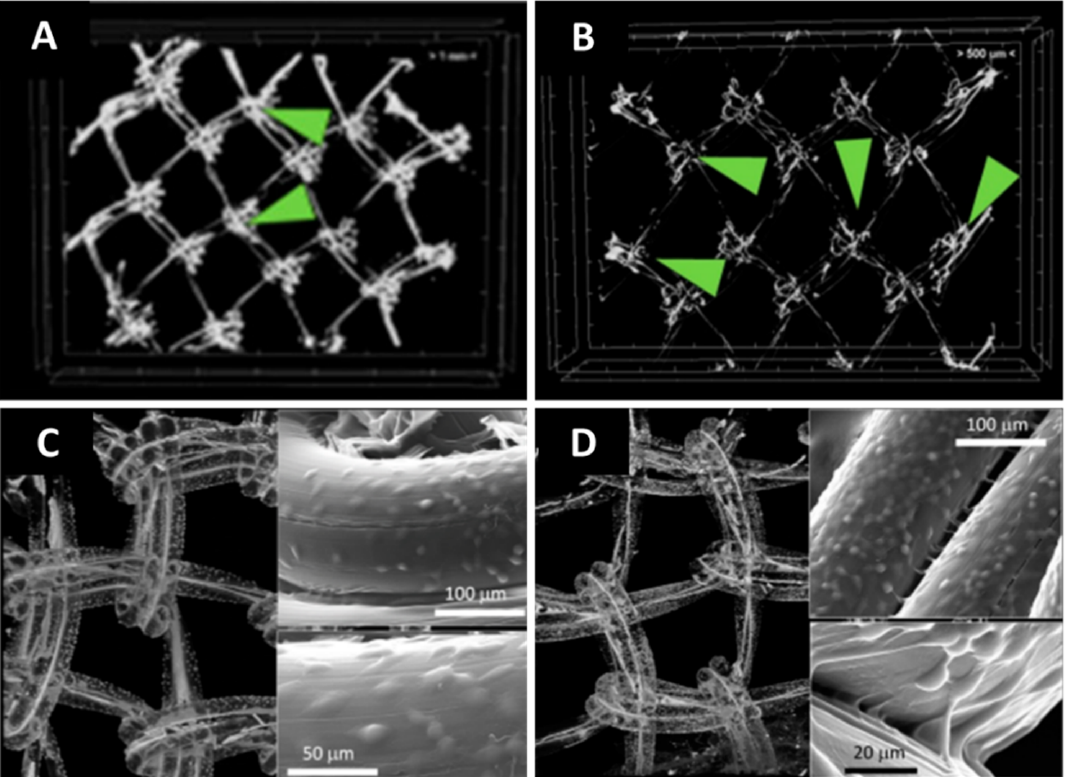
Figure 3. Micro-CT image obtained following coating: ( A ) hydrogel coating on polypropylene mesh following 7 days of testing in acellular conditions, under uniaxial traction ( B ); micro-CT images after cell seeding at 1 ( C ) and 7 ( D ) days, respectively, reproduced after [102] (published under Creative Commons CC BY 4.0